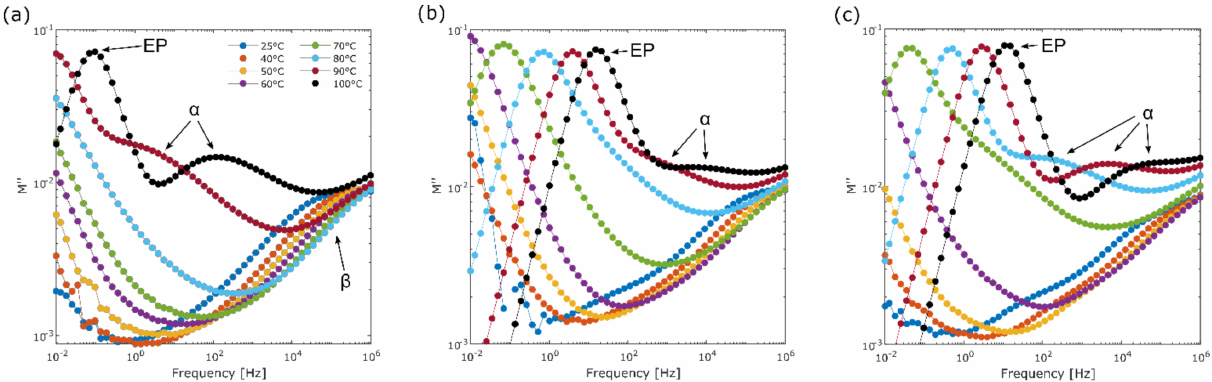
Figure 14. Imaginary moduli of ( a ) Pure epoxy, and nanocomposites with 5 wt.% SiO 2 prepared at ( b ) pH 7 and ( c ) pH 11, from 25–100 ◦ C, showing the α and β relaxations as well as the electrode polarization (EP)